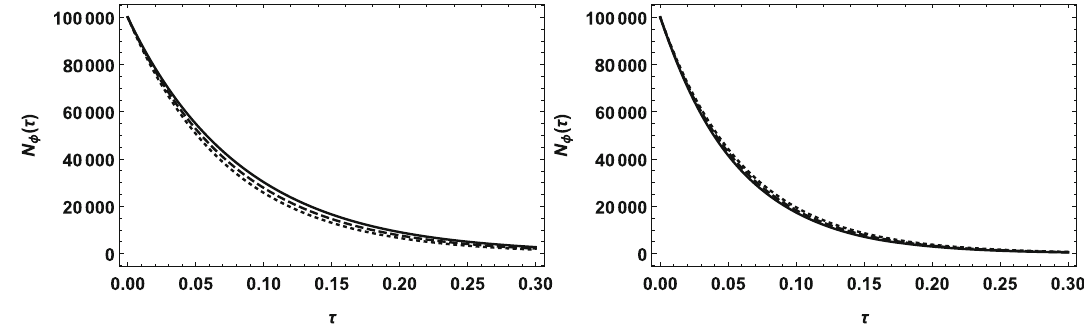
ϕ 2 + ς ϕ 4 and right plot is 2 4